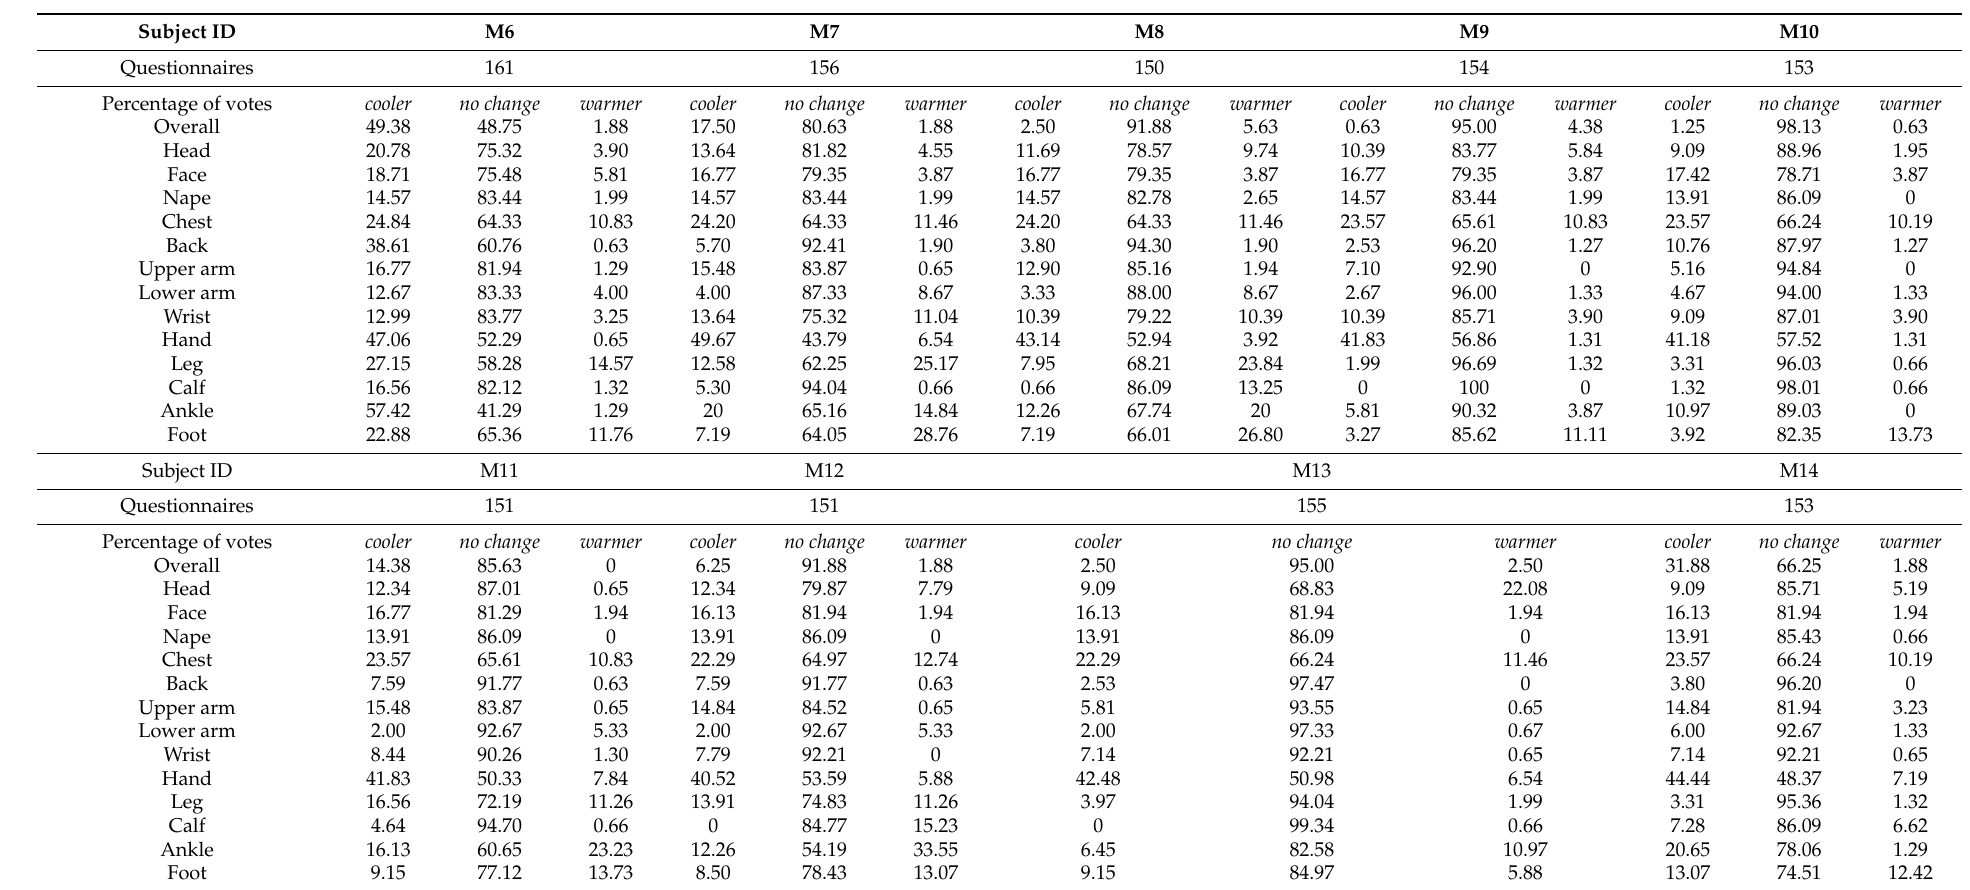
Table A1. The thermal preference votes of the rest of the